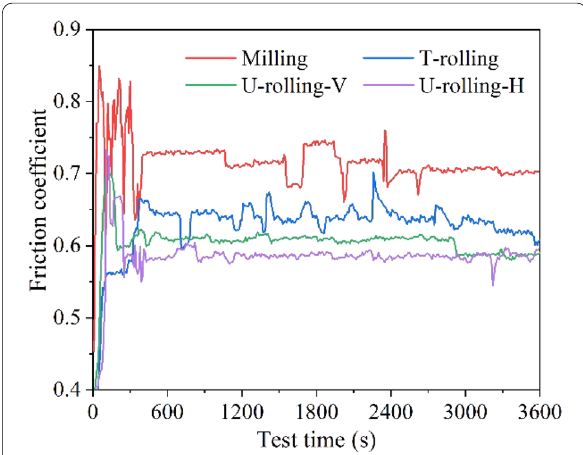
Figure 11 Friction coefficient